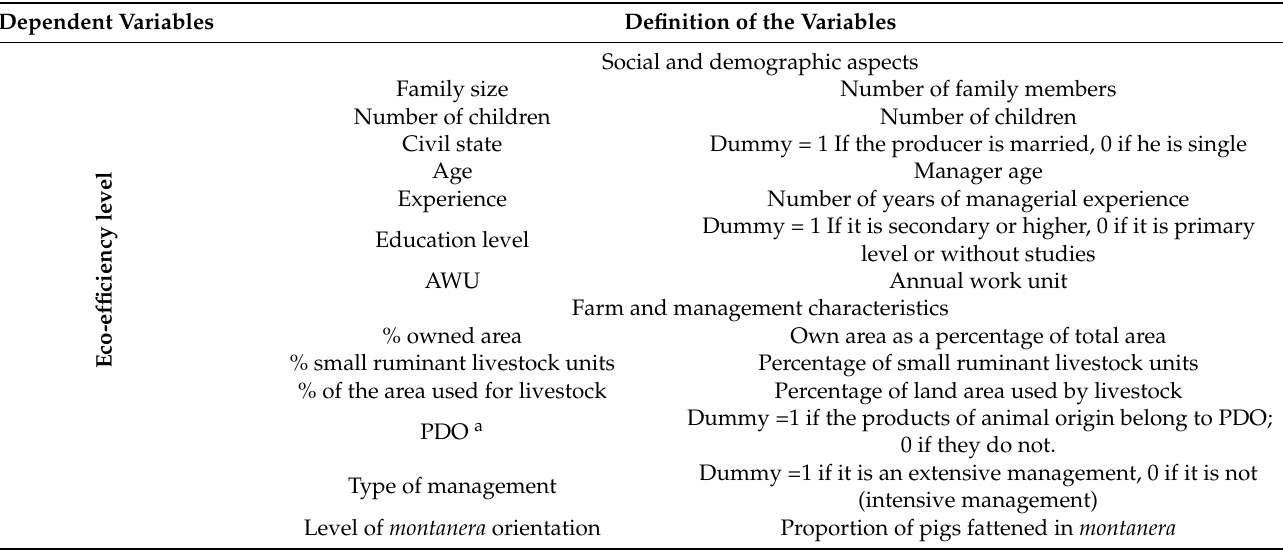
Table 1. Definition of dependent and explanatory variables of the inefficiency used in Tobit models. Dependent